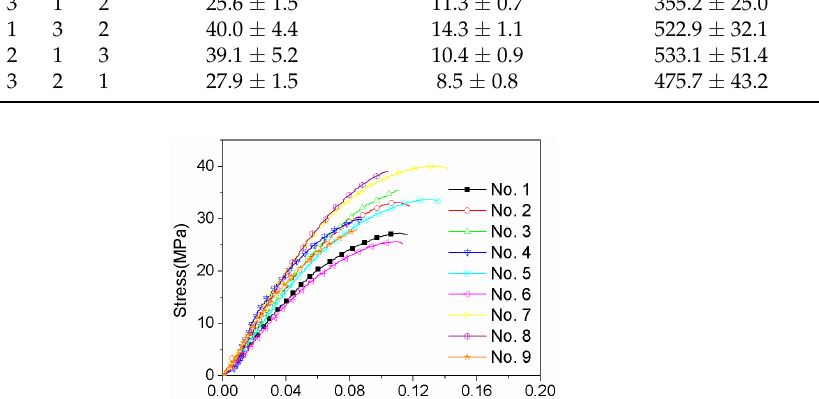
Figure 3. Stress-strain curves of PEEK FDM tensile specimens designed in Table 2.